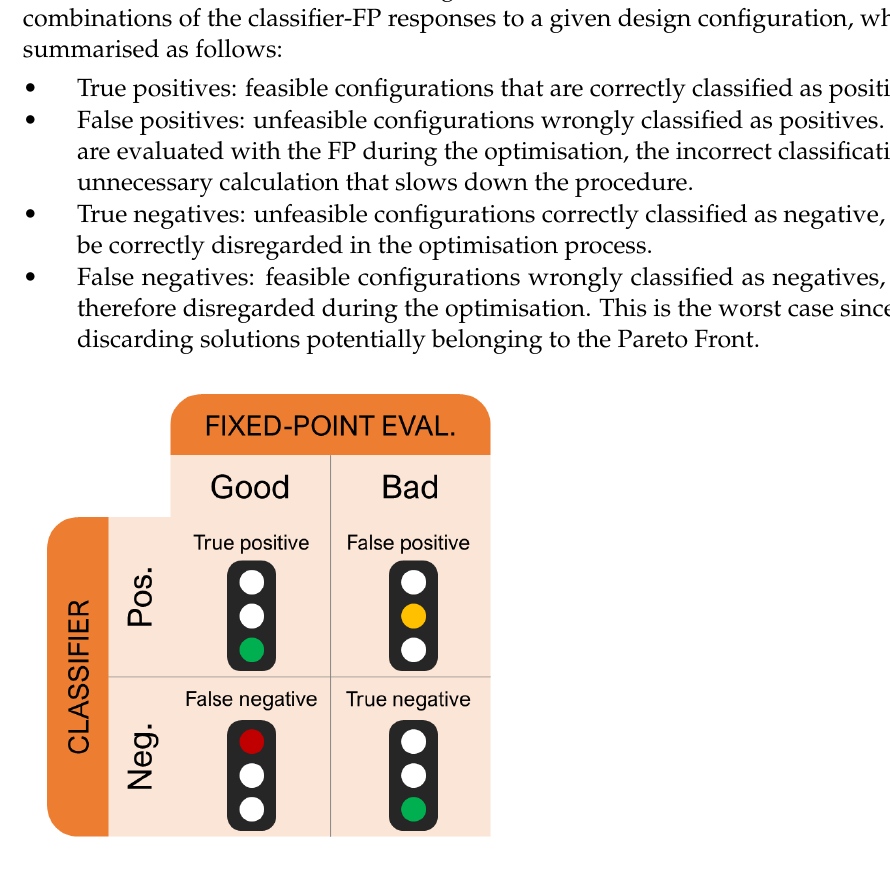
Figure 6. Confusion matrix of the responses given by the classifier system and the evaluation with the FP iterative technique. The traffic lights highlight the effect of the response on the optimisation process: green stands for a correct classification, yellow for an incorrect evaluation that should not affect the output of the optimisation, and red for an incorrect classification which could negatively affect the final